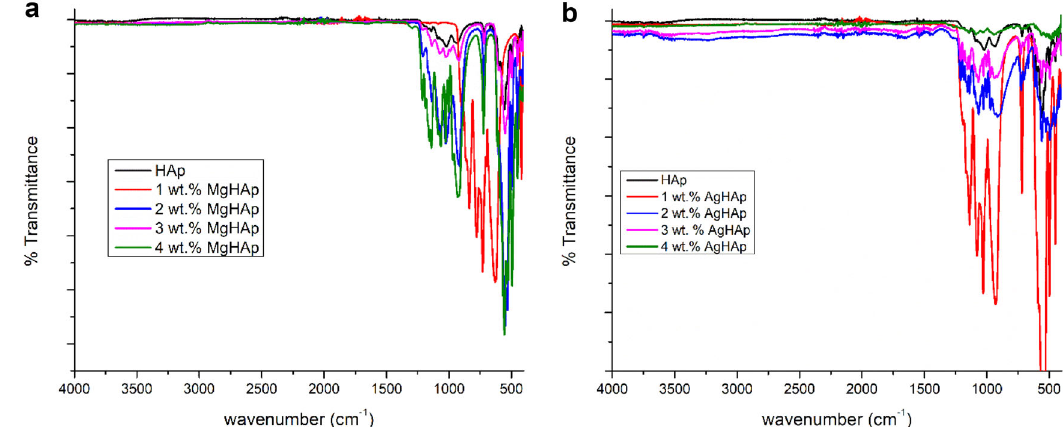
Fig. 2 a The FTIR spectra of pure HAp and all weight percent MgHAp. b The FTIR spectra of pure HAp and all weight percent AgHAp